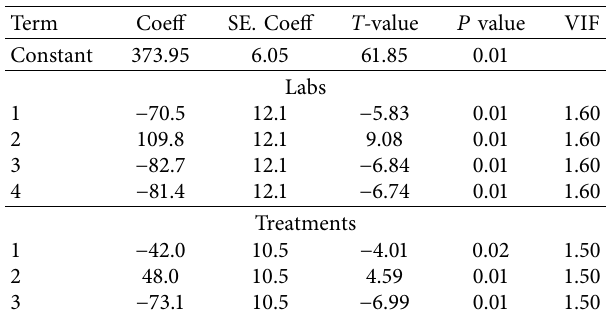
Table 3: Coefcients of